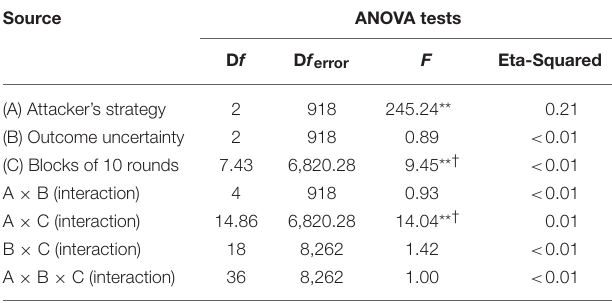
TABLE 2 | Factorial analysis of variance for average choice over blocks of 10